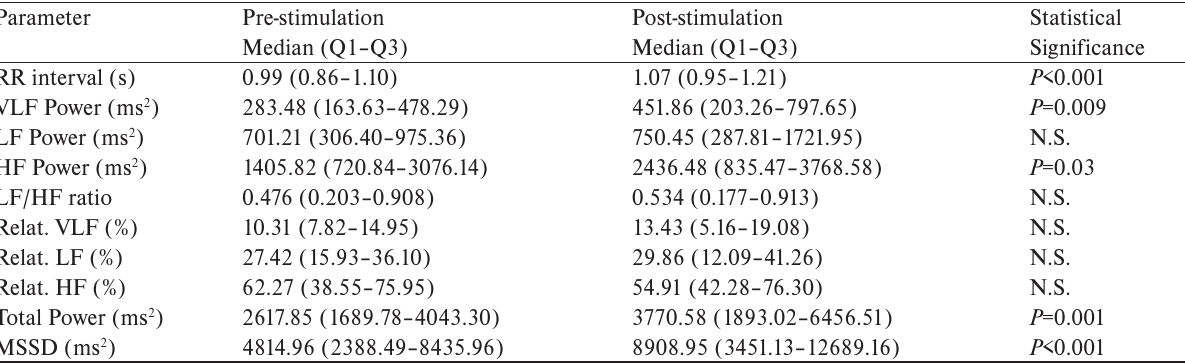
Table 2. Duration of RR intervals and parameters of heart rate variability: ankle (control) stimulation.